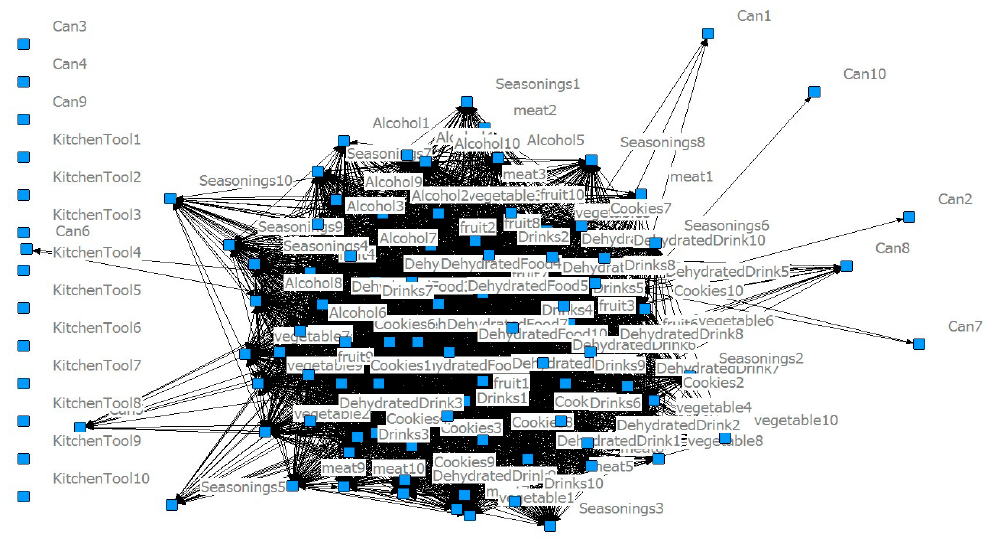
Figure 5. Customer-based network (CBN).